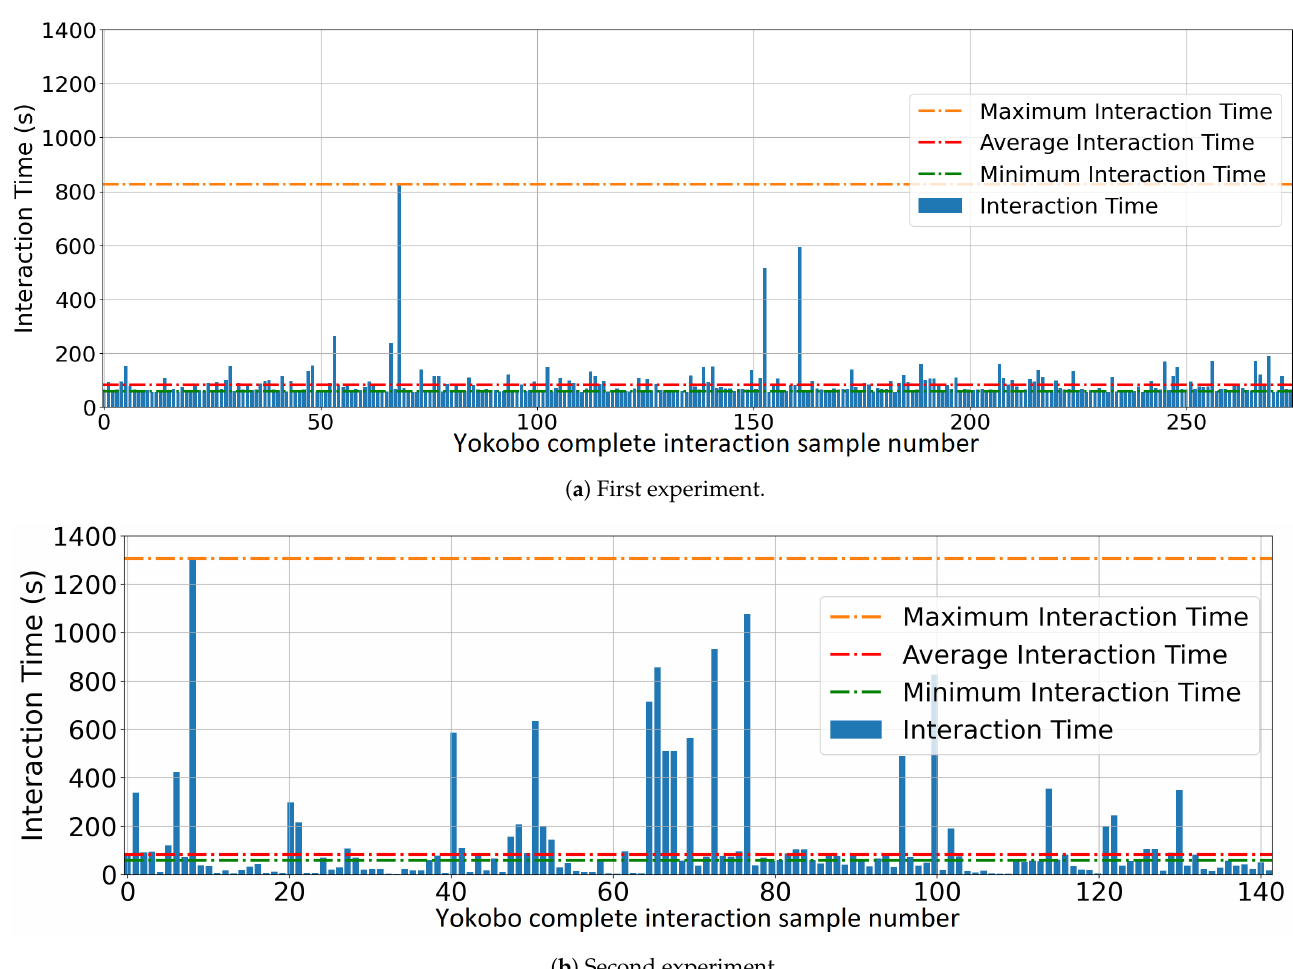
Figure 6. Interaction time throughout both experiments. Each sample represents an interaction with Y¯okobo that completes the states loop, i.e., Wake-Up trigger to the start of the Go Back to Rest state. This interaction time is measured second and composes every interaction without differentiating between SPs or V. The values associated with the minimum, maximum, and average times for both experiments are also shown. The maximum interaction time spent for E1 is 826s, the minimum is 16s, and an average of 76s. For E2 the average is 113.24s, the maximum is 1307s, and the minimum is